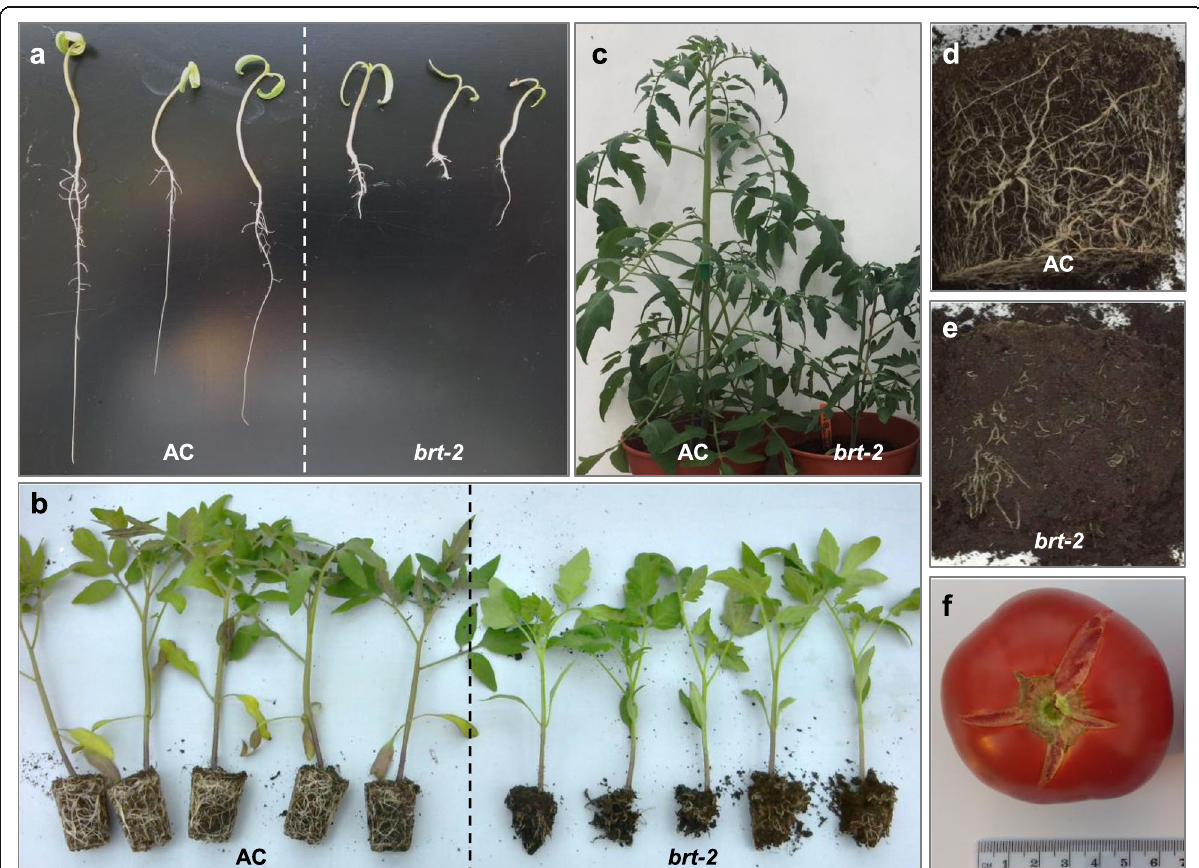
Fig. 1 The brt-2 phenotype. a comparison of seedling growth of brt-2 and AC. b comparison of 4 weeks old AC and brt-2 lines. c 9 weeks old AC and brt-2 plants possess different shoot size. d 9 weeks old AC produces significantly more roots than brt-2 plants e in 10 L pots. f The brt-2 tomatoes usually possess